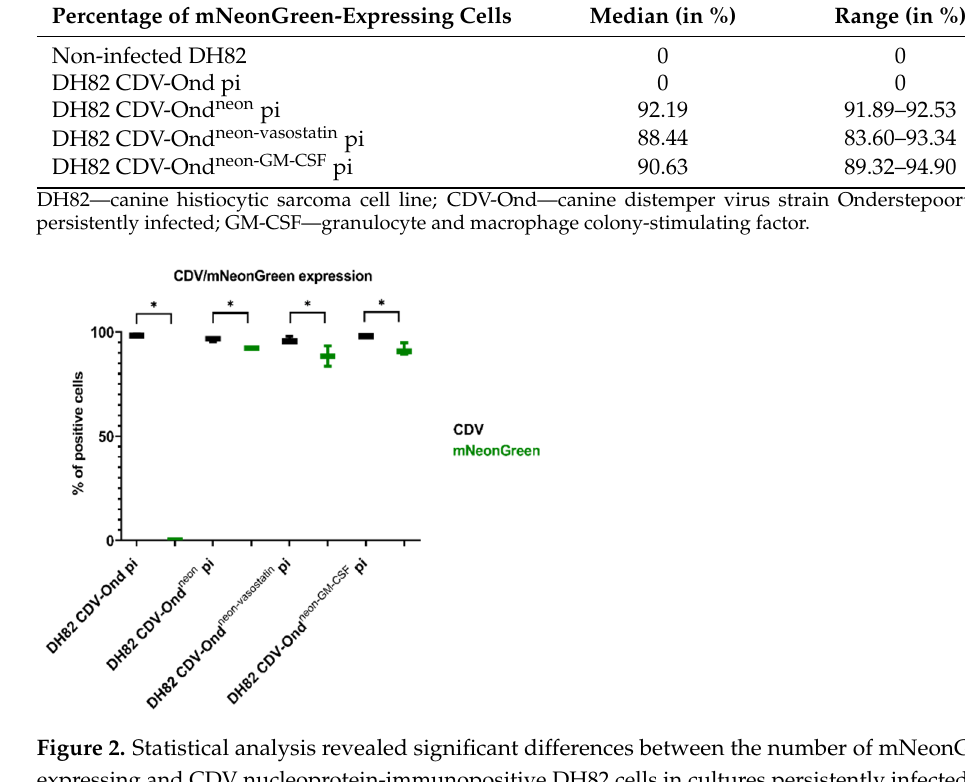
Table 2. Median and range of the number of mNeonGreen-expressing cells. Percentage of mNeonGreen-Expressing